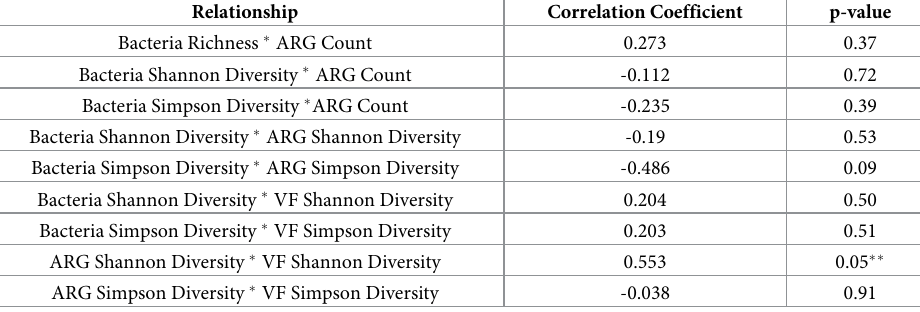
Table 5. Results of Pearson correlation